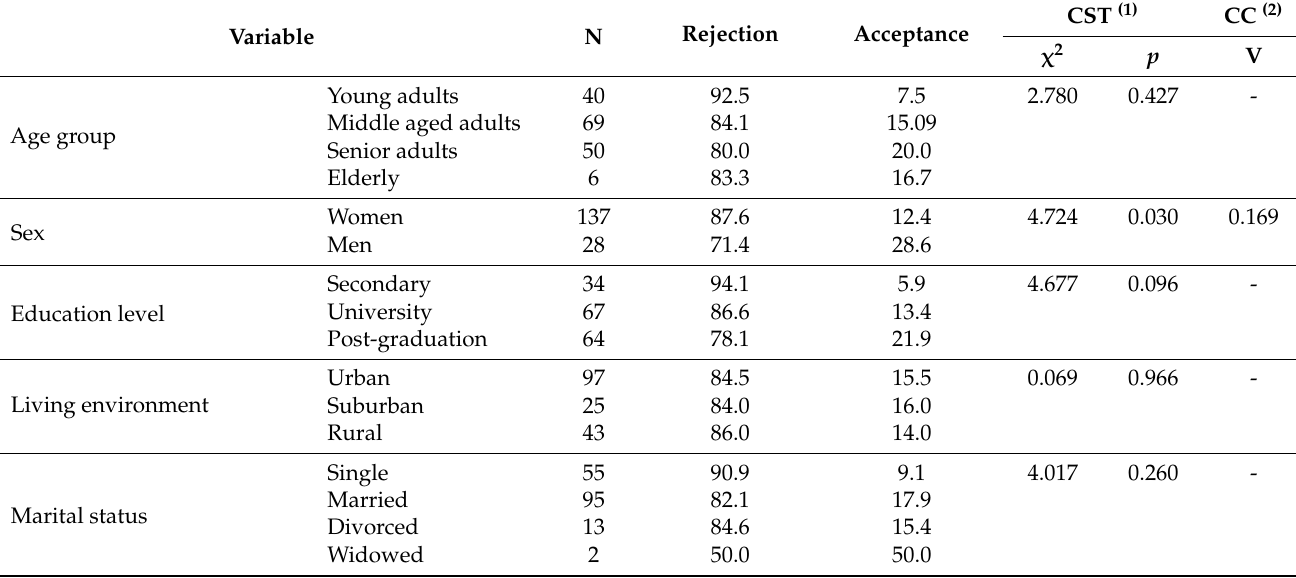
Table 8. Associations between the acceptability of whole EI and the sociodemographic variables studied.